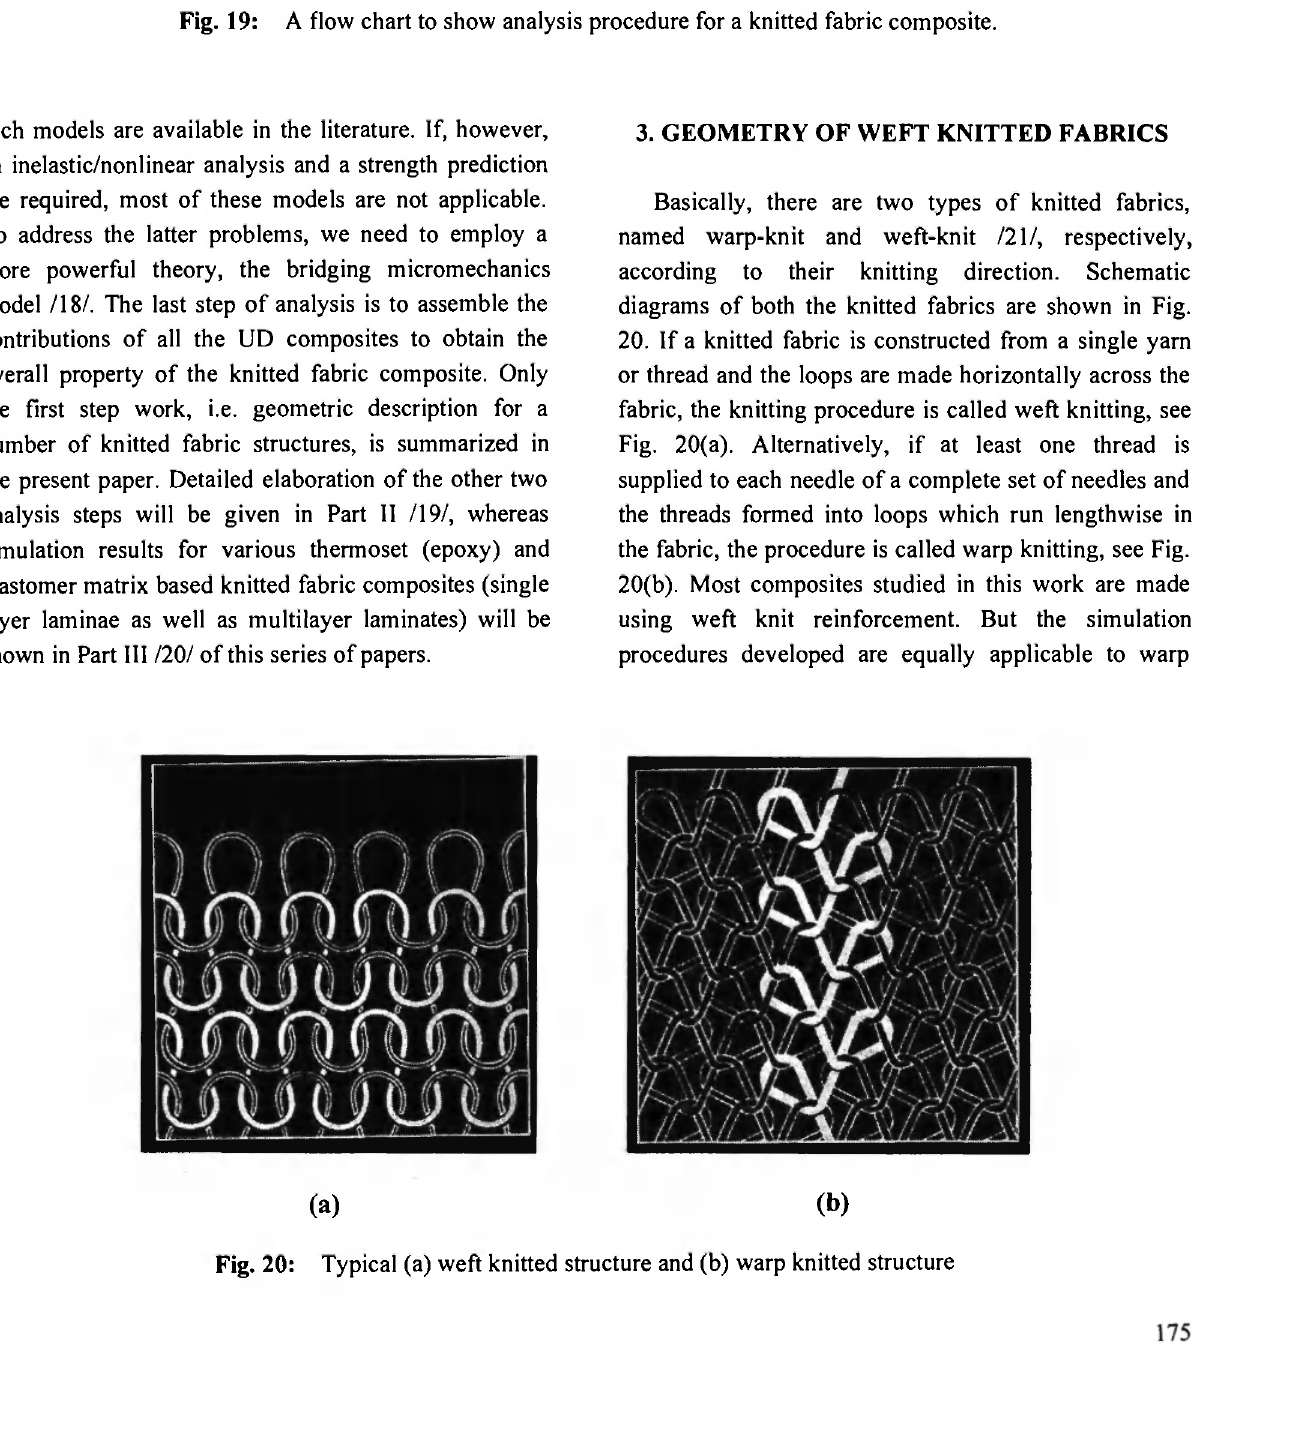
Fig. 19: A flow chart to show analysis procedure for a knitted fabric composite.